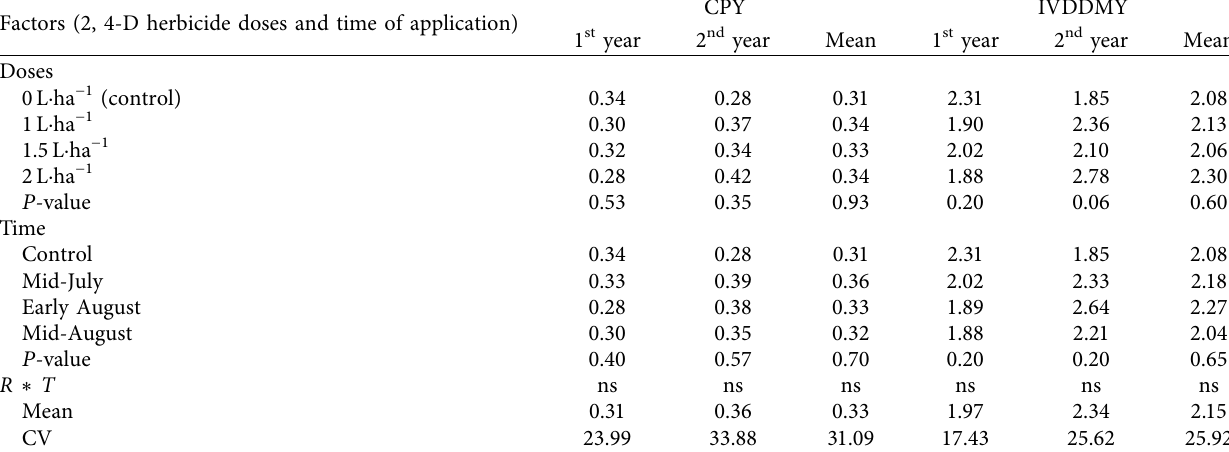
Table 12: Effect of dose and time of application of 2, 4-D herbicide on crude protein and in vitro dry matter digestibility yield (t · ha − 1 ) of forage portion (grasses